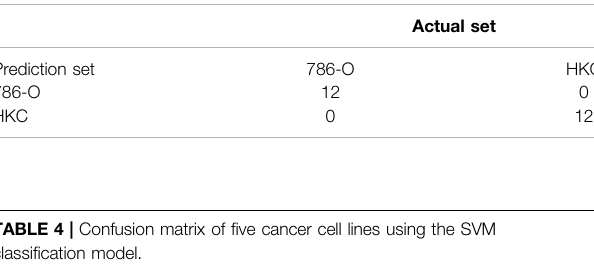
TABLE 3 | Prediction result of cancer cells/normal cells with SVM classi fi cation.